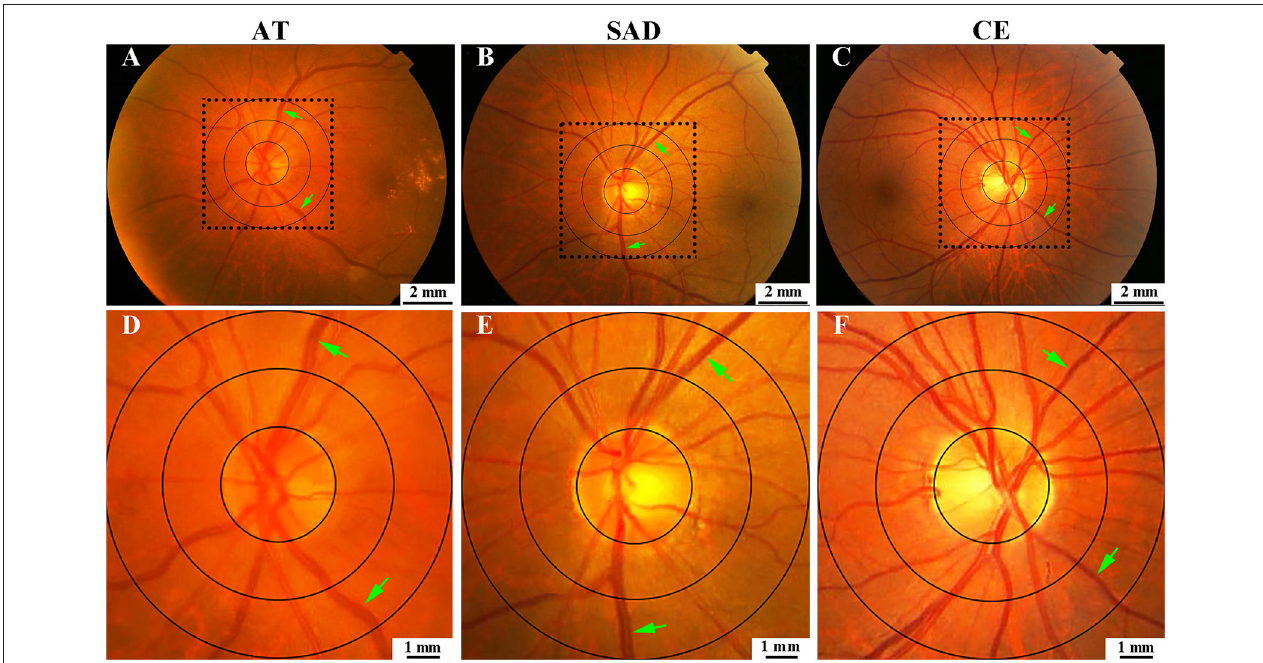
FIGURE 5 | Comparison of MVD 0.5 − 1.0DD among AT, SAD, and CE subtypes. (A) was for AT, (B) was for SAD, (C) was for CE. (D–F) were the magnified images of the selected areas in (A–C) , respectively. AT, atherothrombosis; SAD, small artery disease; CE, cardioembolism; DD, disk diameter; MVD, mean venular diameter.